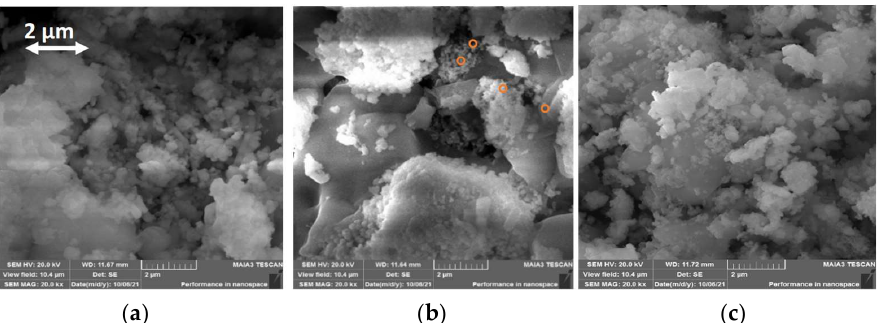
Figure 3. SEM images of NEHEOs [Al 0.35 (Mg, Fe, Cd, Cr, Mn) 0.65 ] 3 O 4 ( a ) [Al 35 (Mg, Fe, Cu, Ni, Co) 65 ] 3 O 4 ( b ); the orange circles signify the nanosized spheroids) [Cu 0.35 (Al, Fe, Co, Cr, Ni) 0.65 ] 3 O 4 ( c ) at 2 µm resolution.